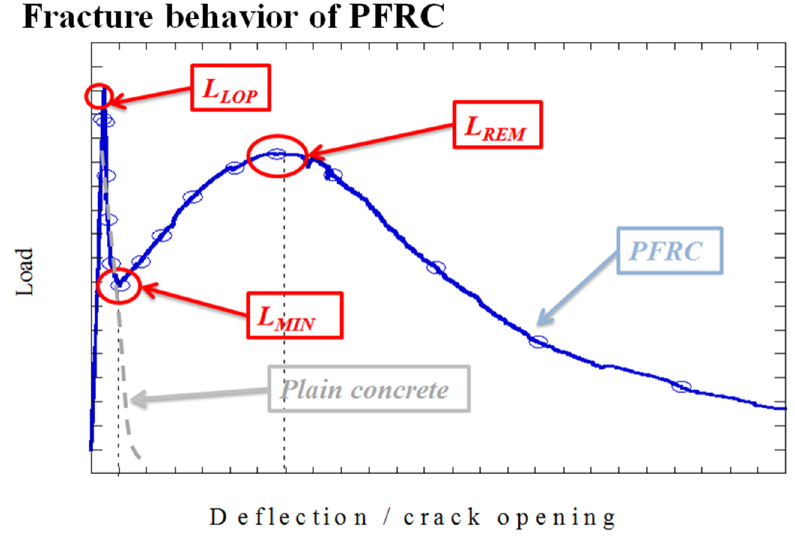
Figure 10. Sketch of the typical fracture curve of